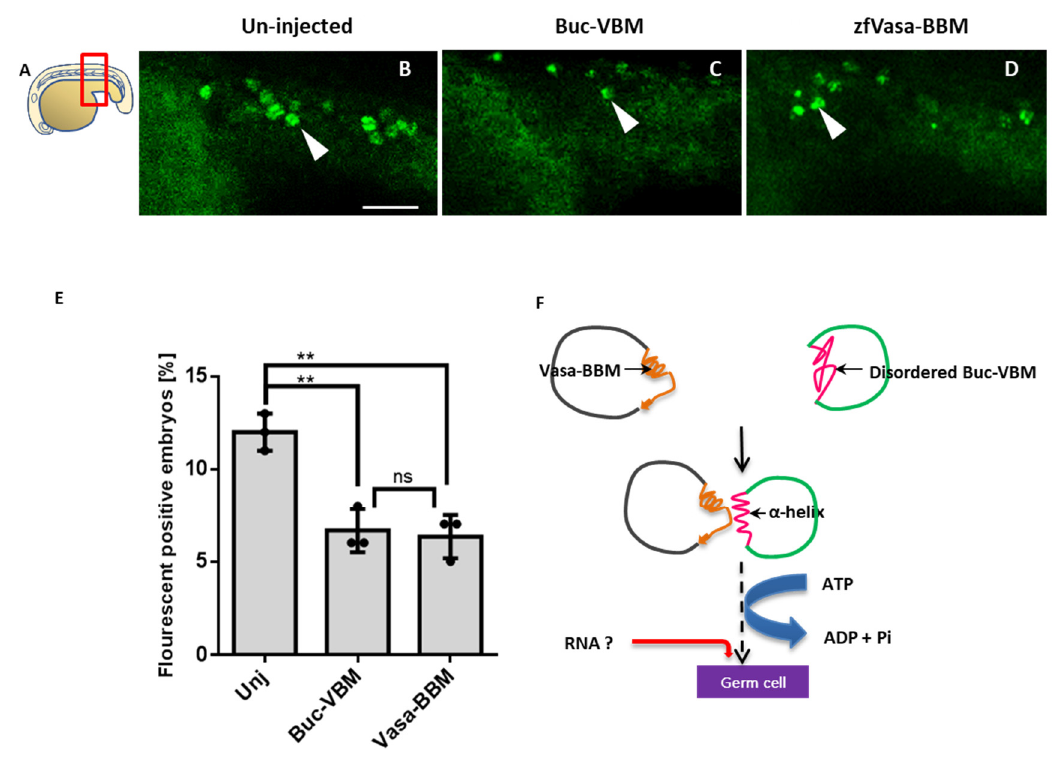
Figure 6. Buc-VBM and zfVasa-BBM inhibit germ cell specification in vivo. ( A ) Cartoon representation of the lateral view shown in panels ( B – D ) of 15–18-somite stage zebrafish larvae, with the animal to the left. Imaging area boxed in red. ( B ) Live un-injected embryos with fluorescent germ cells (green cells (white arrow); transgenic for Buc-GFP). ( C ) Embryos injected with Buc-VBM and ( D ) zfVasa-BBM. ( E ) Quantification of the germ cell number. Embryos injected with either Buc-VBM (6 ± 1.0, n =18) or zfVasa-BBM (6.3 ± 1.1, n = 16) showed a reduction of germ cells compared to the un-injected embryos (12 ± 1.6, n = 15). Additionally, we did not observe a significant statistical difference between Buc-VBM and zfVasa-BBM. The data presented are averaged from three independent experiments. The Y-axis represents the average germ cell count, and the X-axis represents the injected constructs Buc-VBM and zfVasa-BBM. Error bars represent the standard deviation of the mean. ( F ) Hypothetical model of the Buc-zfVasa interaction. Buc (green line) binds directly to zfVasa (black line) through zfVasa-BBM (orange) and Buc-VBM (pink). During the interaction, disordered Buc-VBM adopts an α -helical structure. Conversely, Buc-VBM stimulates the ATPase activity of zfVasa (blue arrow), which is further enhanced when RNA (red line) binds to zfVasa. The helicase activity probably triggers an unknown downstream RNA processing specifying primordial germ cell development. Scale bar 50 μ m. Test statistics: Student’s t -test, ** = 0.01. ns = nonsignificant.